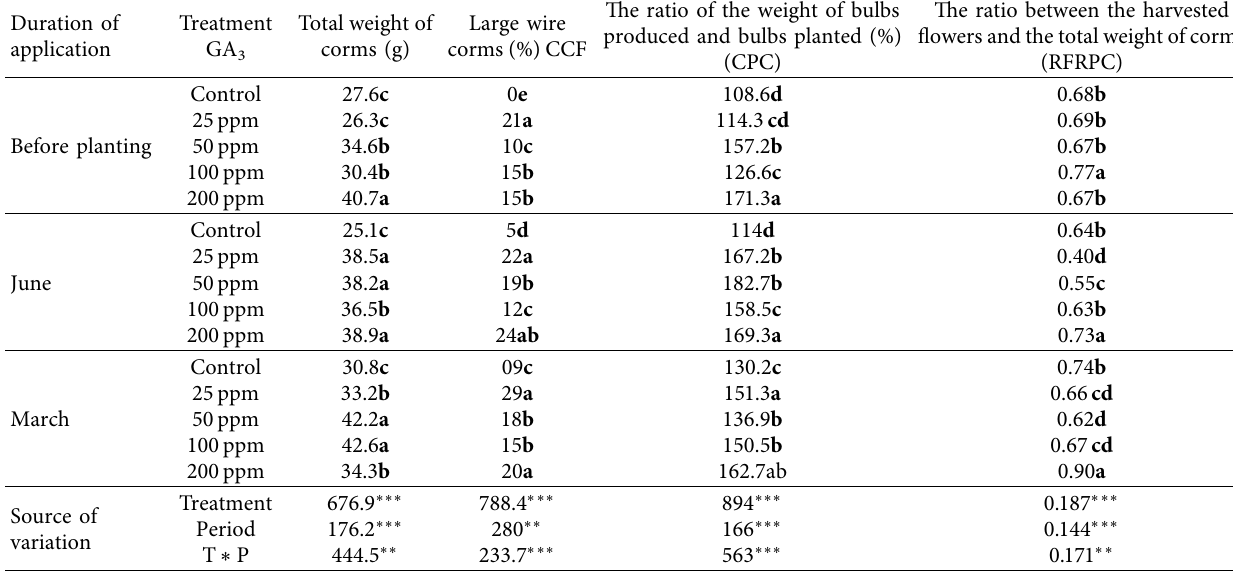
Table 6: Effect of different GA 3 concentrations and duration of application on the total weight of corms, the percentage of large-diameter wire corms, the coefficient of corm propagation and the ratio of harvested flowers to total corm weight. Values with the same letter in each application period in the column are not significantly different ( p � 0 . 05); ns: not significant; ∗ significant at 5%; ∗∗ significant at 1%, ∗∗∗ significant at